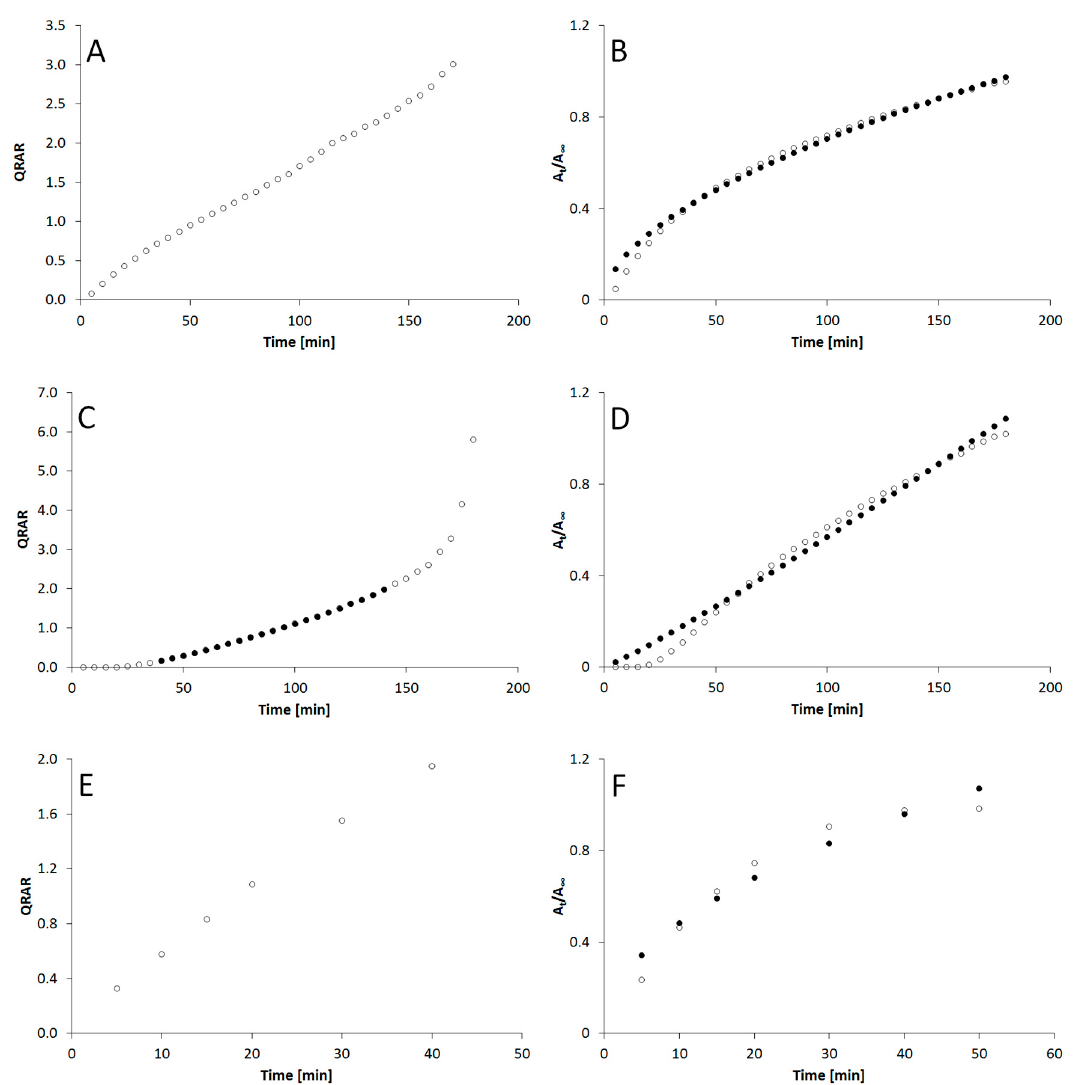
Figure 2. The Hixson–Crowell ( A , C , E ) and Korsmeyer–Peppas ( B , D , F ) kinetics, applied to evaluated preparations: FEP1 ( A , B ), FEP2 ( C , D ) and FEN3 ( E , F ) respectively. The filled circles on panel C represent the partial fitting of the data to the Hixson–Crowell model in the case of FEP1. The filled circles on the panels B, D, F represent the data calculated for the Korsmeyer–Peppas model according to the best fitted section of the graph in the SOLVER application, whereas the empty circles on these panels represent the surrogate data transformed according to the model. The empty circles on the axis x on panel D should not be included for the consideration of Korsmeyer–Peppas model for FEP2. QRAR—cubic root of the amount of released drug, A t /A ∞ the ratio of the amount of drug released at time t to the total released amount of drug.